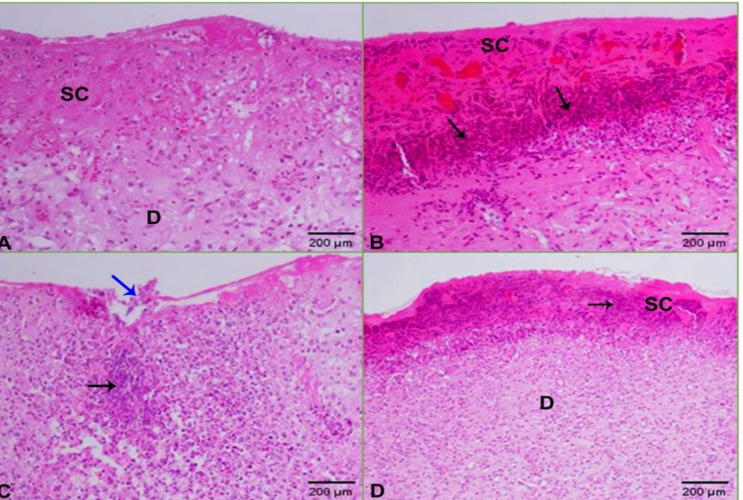
Figure 8. Photomicrographs of skin at day seven after wounding: ( A ) uninfected and untreated wounded skin showing a wide scab ( SC ) and scattered inflammatory cells in the dermis ( D ); ( B ) in- fected and untreated wounded skin revealing a scab ( SC ) interspersed with hemorrhage and granu- loma (arrows); ( C ) infected and wounded skin treated with ZnO-NPs displaying a thin layer of scab with a wound edge (blue arrow) under which was a wide dermis area filled with inflammation (black arrow); ( D ) infected and wounded skin treated with imipenem exhibiting a scab (SC) interspersed with granuloma (arrow) and wide dermis ( D ) area filled with inflammatory cells (HE: 200 × ).